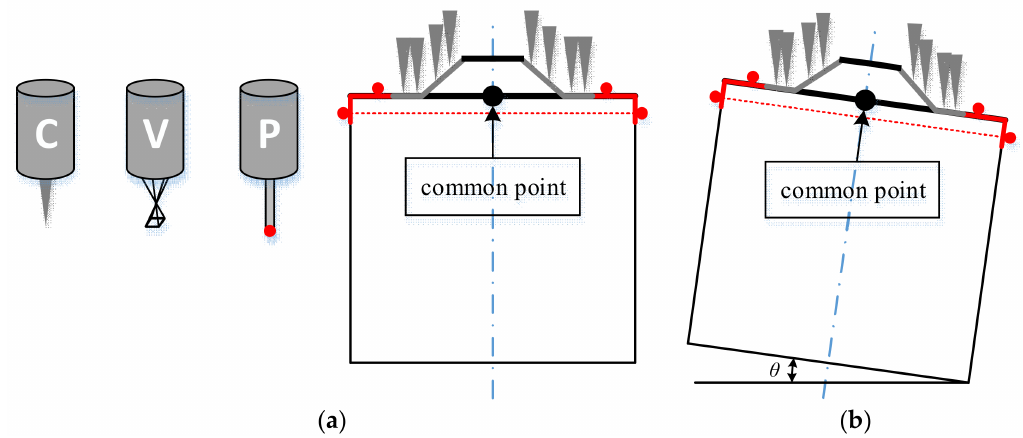
Figure 7. The standard measured by the three sensors: ( a ) diagram of the three sensors and ideal state of the standard; ( b ) inclined